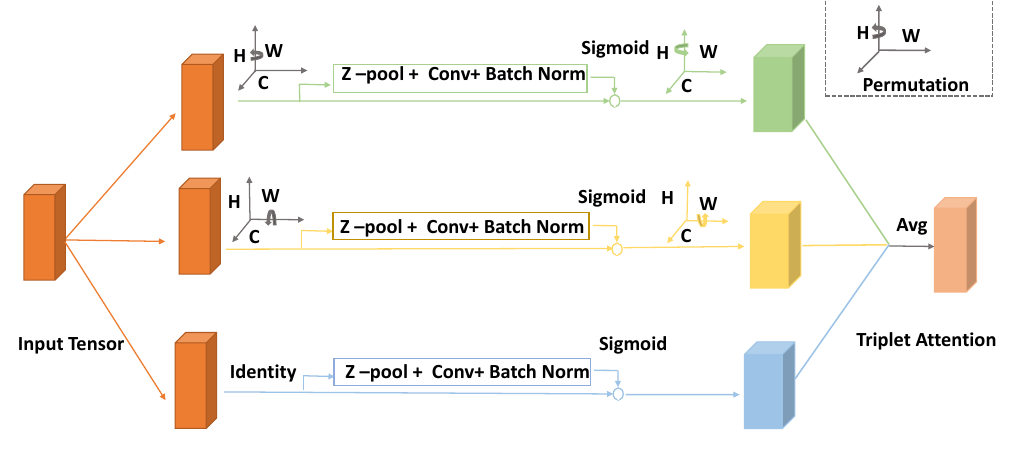
Figure 1. Detailed architecture of the triplet attention mechanism, which calculates attention weights based on a three-branch structure to capture cross-dimensional interactions. The first branch (green) computes channel dimension C and spatial dimension W , the second branch (yellow) captures channel dimension C and spatial dimension H , and the third branch (blue) computes spatial dependencies between H and W . The final output is an average of the resultant feature maps of the